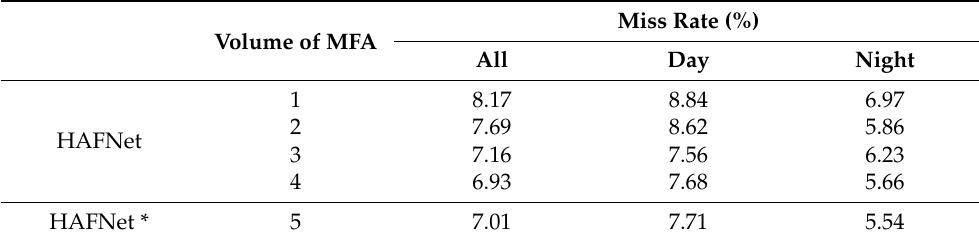
Table 8. Ablation on the multi-modality feature alignment (MFA) block. The MFA block is plugged into the feature extraction module of HAFNet from stage 2 to stage 5.